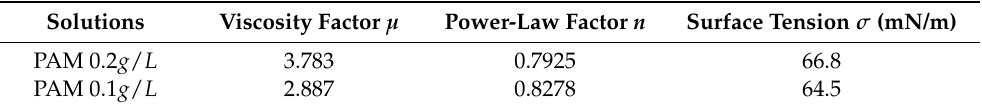
Figure 5. Viscosities of polyacrylamide (PAM) solutions for differing PAM concentrations. The symbols are measured values. The solid lines are the power-law model fit. The corresponding rheological parameters are listed in Table 2. Table 2. Rheological parameters.